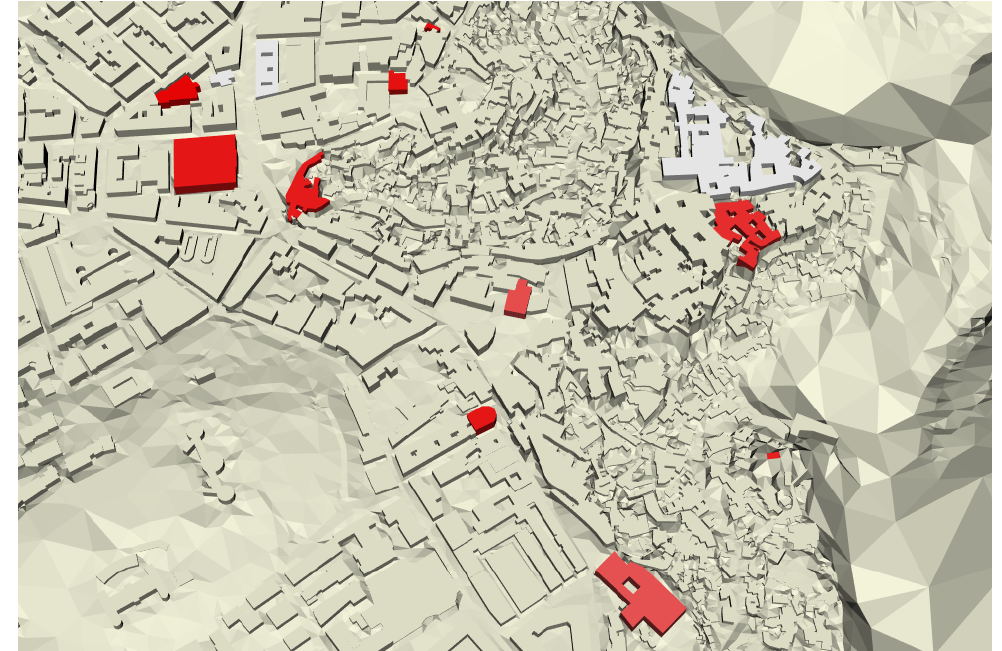
Figure 10. Example of visualization of further geo-referenced information from real-time sensors: from white to red, increasing occupancy rate of Points of